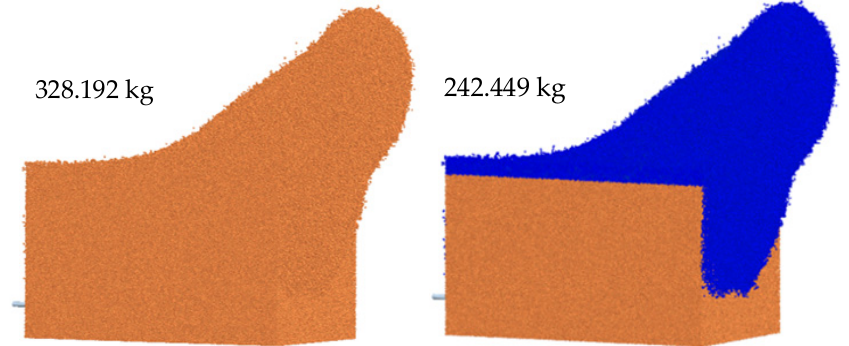
Figure 14. Soil granular bed quality statistics. Table 8. Results of fluid–soil coupling test.